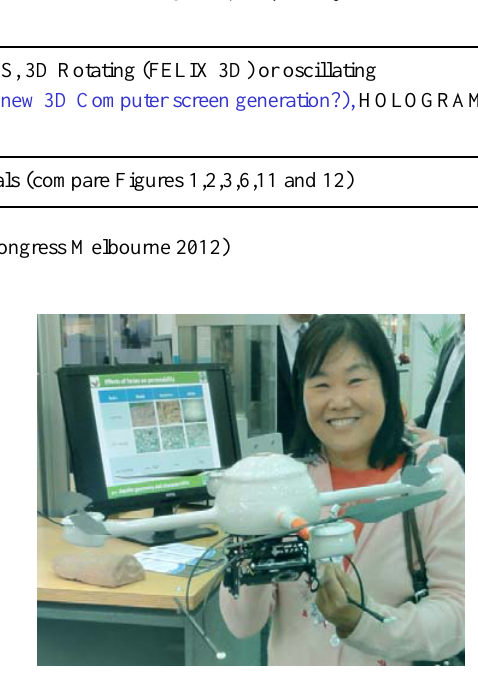
Figure 9. Ground steered civil drone platforms, carrying on board GPS and digital cameras, promise a great future (photography by W.